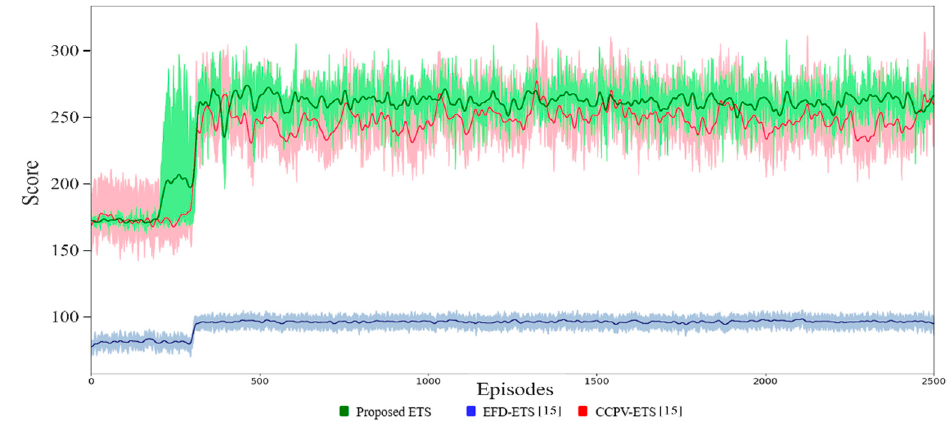
Figure 4. The DDQN learning curve showing score convergences for episode 2500 using the proposed double Kelly, EFD [15], and CCPV [15] strategies.